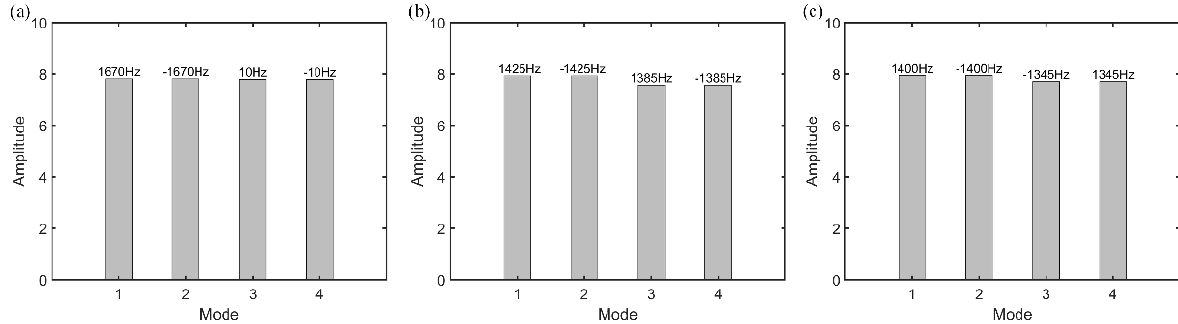
Figure 13. Energy − frequency diagram of the first four modes by DMD (( a ) S = 0.44, ( b ) S = 0.6, ( c ) S = 0.71).